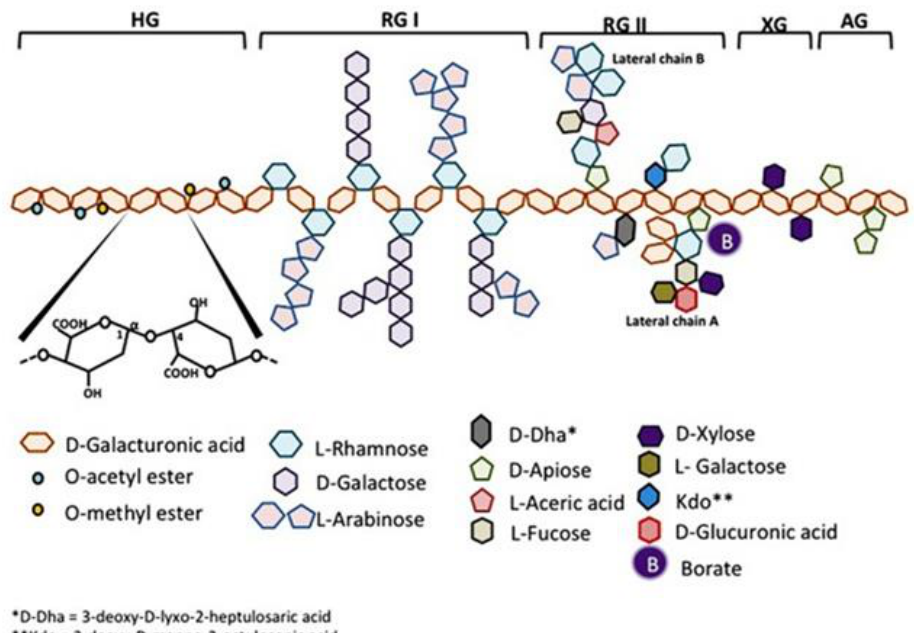
Figure 1. Schematic representation of pectin structure. AG, arabinogalactan; HG, homogalacturonan; RG, rhamnogalacturonan; XG, xylogalacturonan. It is reproduced with permission under a Creative Commons Attribution License (CC BY 4.0) https://creativecommons.org/licenses/by/4.0/ from Leclere, L.; Cutsem, PV.; Michiels, C.; Anti-cancer activities of pH- or heat-modified pectin. Front Pharmacol . 2013 Oct 8; 4:128. [1]